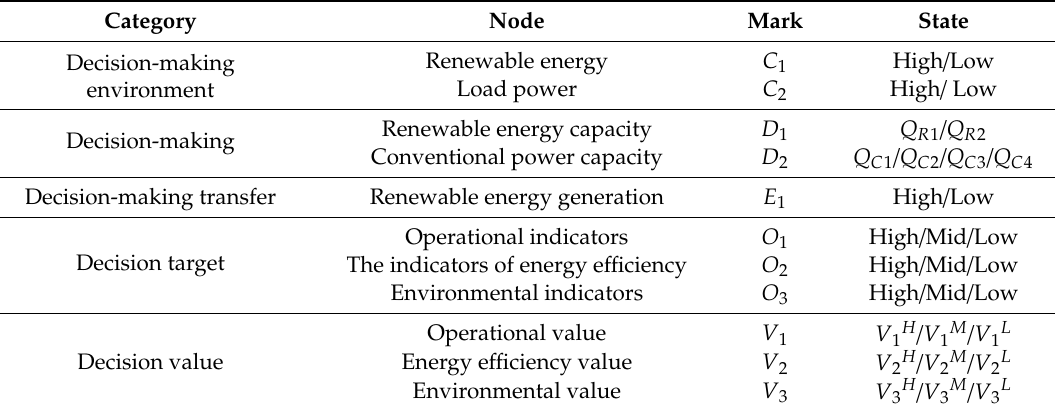
Table 3. Influencing factors node descriptions for sustainable generation expansion planning.